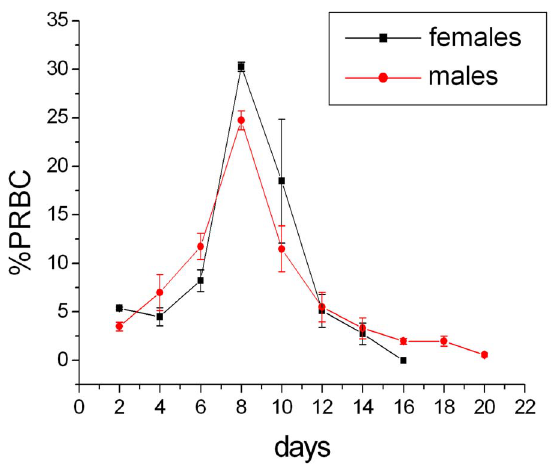
Figure 1. The parasitemia kinetics of P.chabaudi infected Balb/ C mice. The parasitemia was calculated from RBCs counted on Giemsa stained blood smear. 400–500 RBCs were counted in each case.